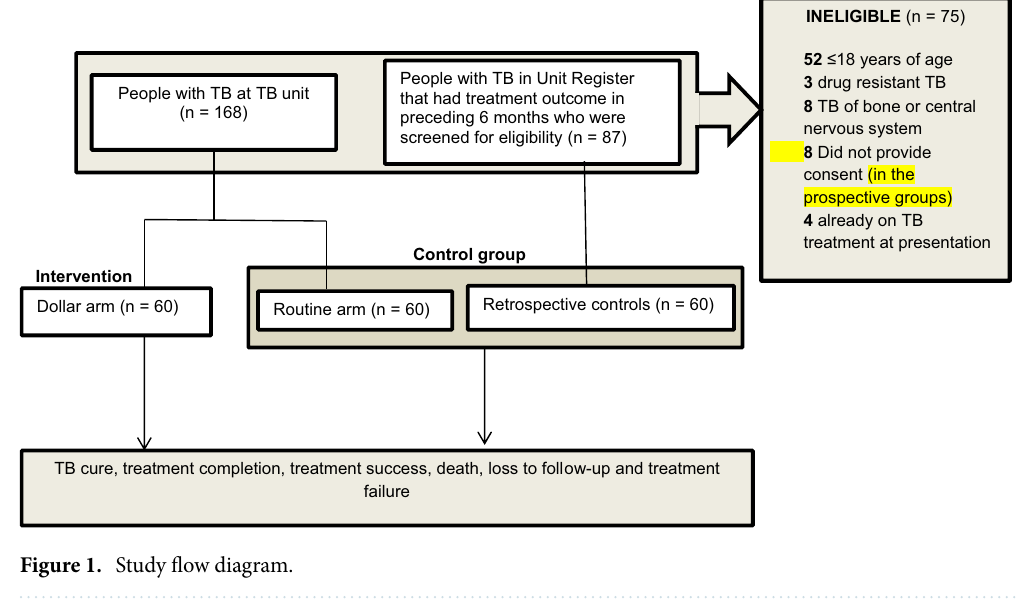
Figure 1. Study flow